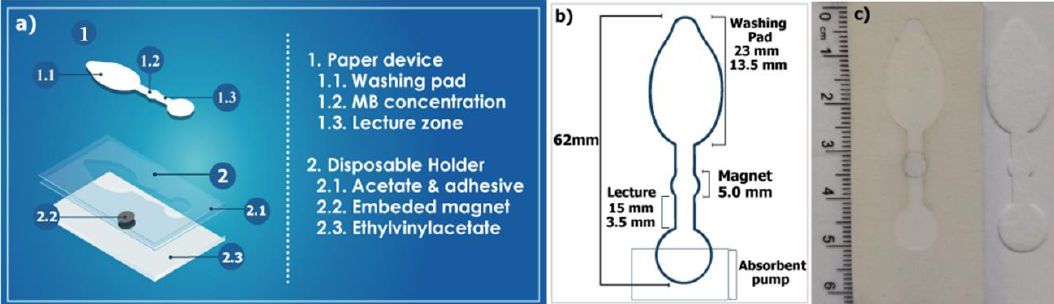
Figure 1. ( a ) Schematic representation of the system developed, which resembled that described in [28] but displayed different geometric features. ( b ) Dimensions of the single-piece paper device. ( c ) Picture of the reusable magnetic holder (left) and the disposable paper device produced with Standard 17 membrane (right).